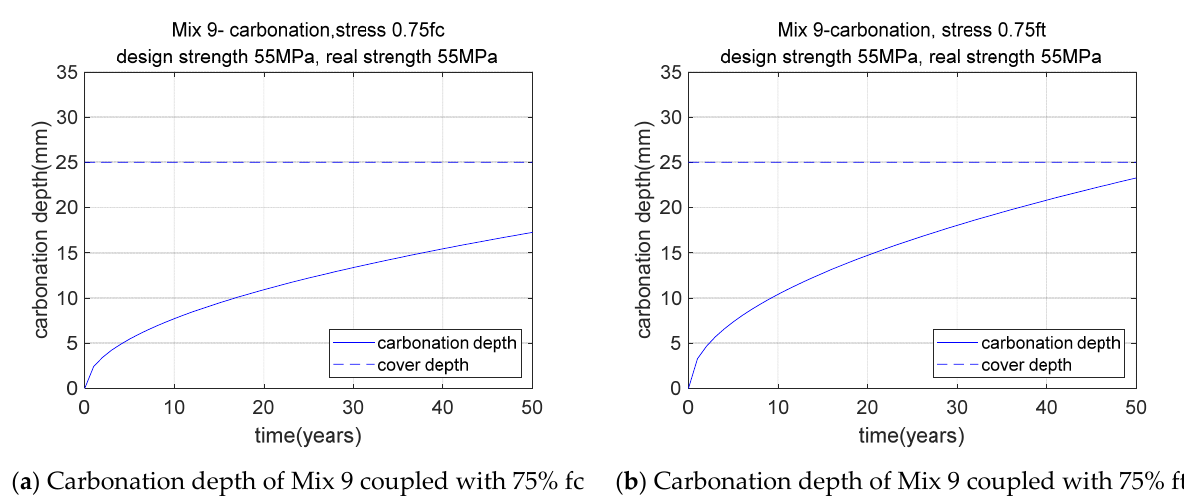
Figure 4. Carbonation depth of case study 4: design for concrete with high strength (Mix 9).